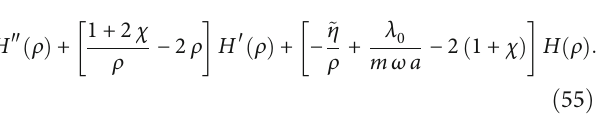
. In Figure 7, the energy eigen- E 1 , 1 against the parameter η c values E 1 , 1 against the parameter M . In Figure 8, the energy eigenvalues E 1 , 1 against the parameter ω . In Figure 9, the energy eigenvalues E 1 , 1 against the parameter Φ .